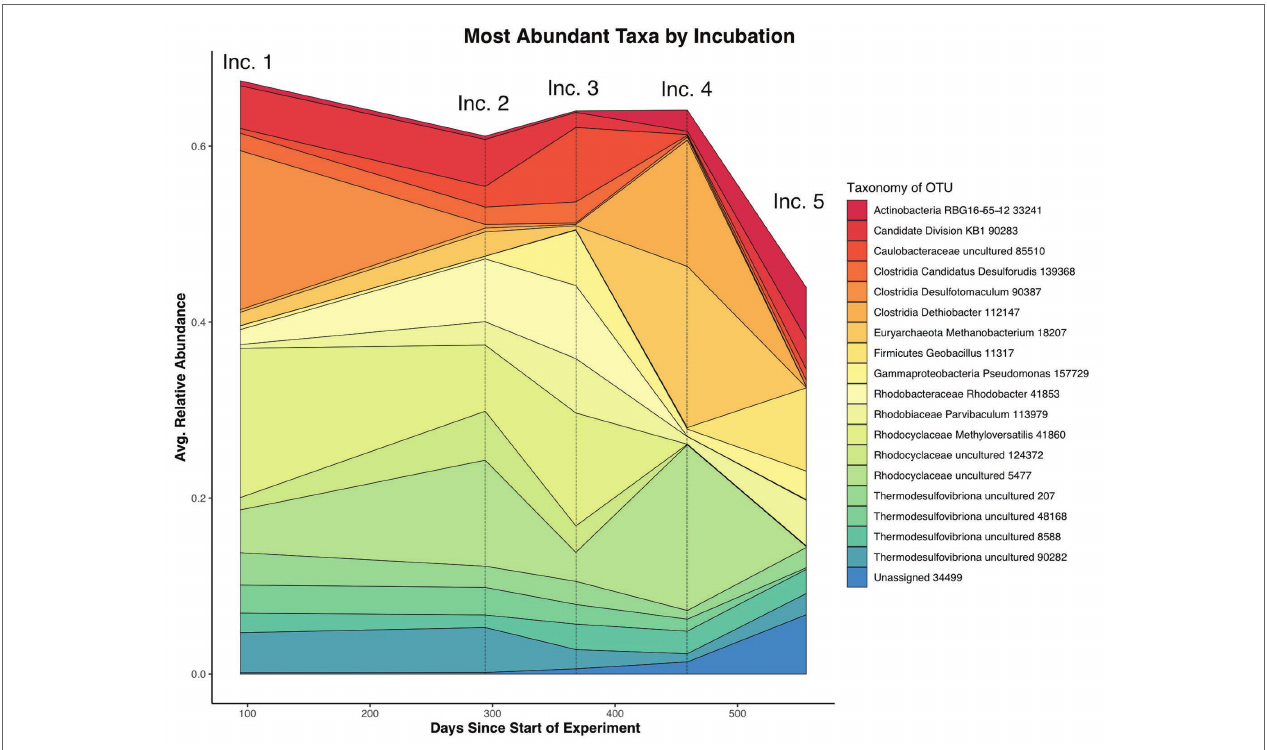
FIGURE 5 | Average relative abundance of most abundant taxa by days since the start of the experiment, with individual incubation collection points noted above. The relative abundance as measured by 16S rRNA iTag data from mineral substrates common to all incubations was averaged at each time point. The data demonstrate the large relative abundance decrease in the Desulfotomaculum OTU co-occurent with the loss of framboidal iron sulfides in Incubation 2 as well as the large bloom in a Methanobacter OTU in Incubation 4 (6 months after organic substrate amendment). Incubation 5 displays a general increase in the proportion of rare taxa relative to the